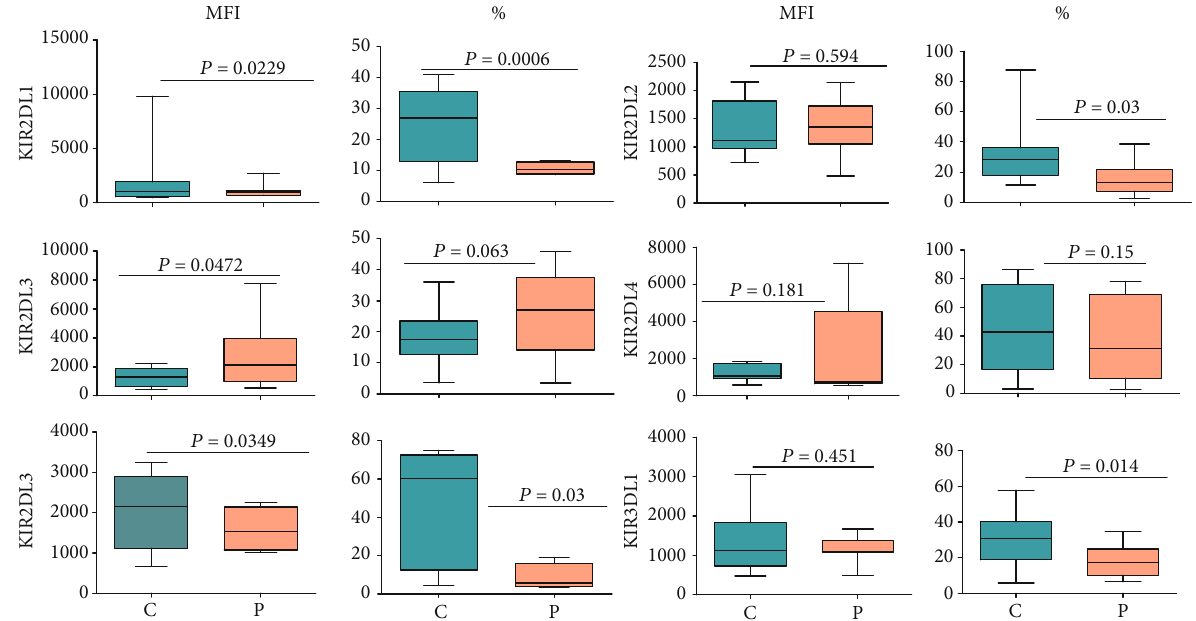
Figure 3: Expression of inhibitory KIR on NK cells in 15 treatment-naïve CD patients and 15 healthy controls. The cells were stained and gated as described in the legend of Figure 2 and stained for antibodies speci fi c for inhibitory KIR as described in Materials and Methods. The fi gure shows median, upper and lower values, interquartile range, and p values.